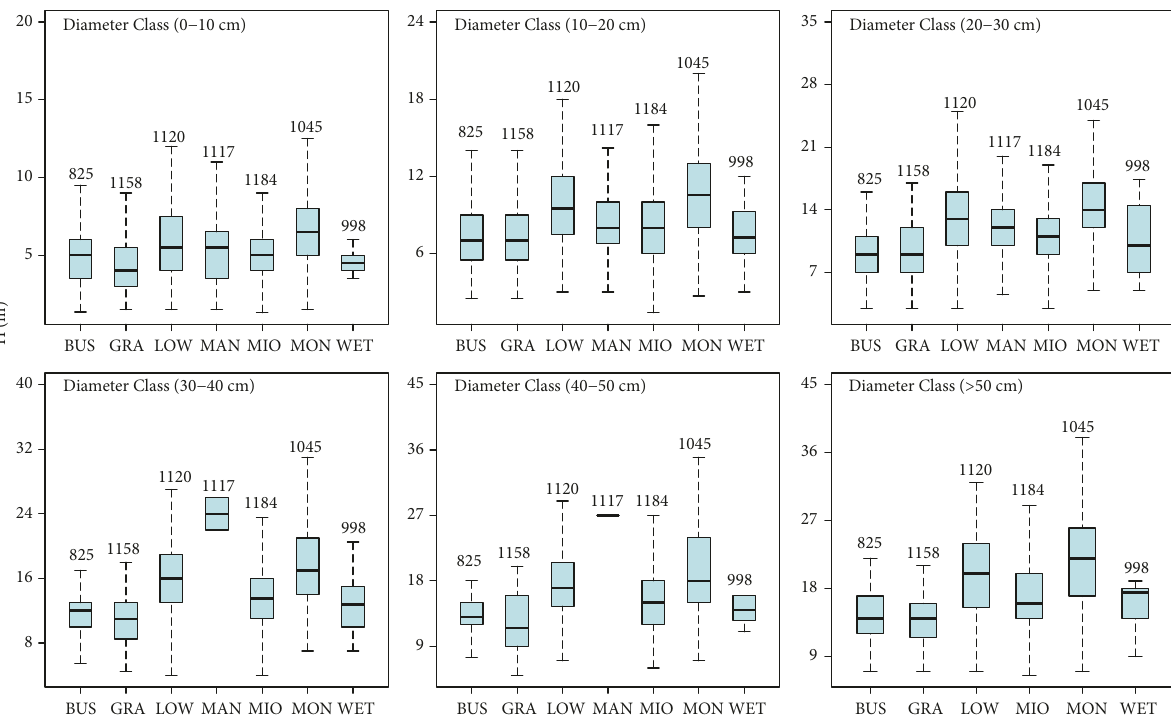
Figure 5: Effect of precipitation to total tree height distributed in diameter classes. PR GRA: Grassland; LOW: Lowland; MAN: Mangroves; MIO: Miombo; MON: Montane; and WET: